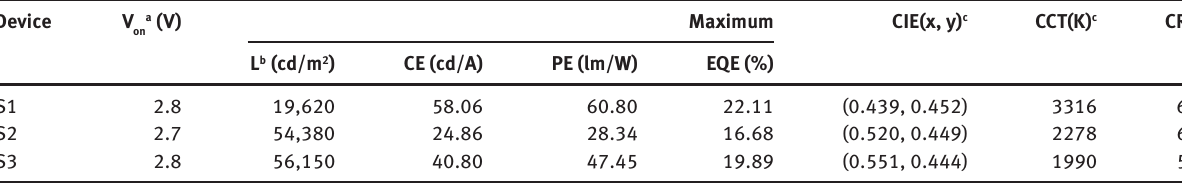
Table 2: The EL performance parameters summary of single unit white devices S1–S3.